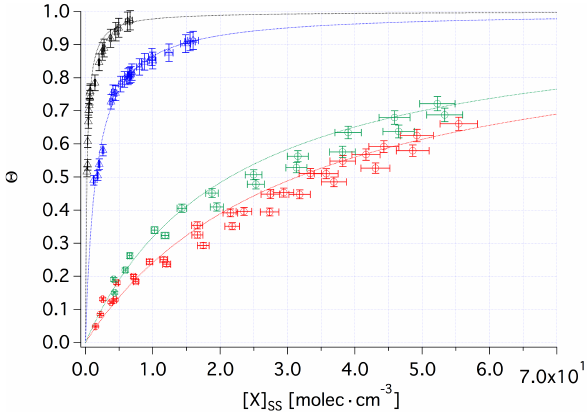
Figure 2: Wall coverage as a function of HCl and H 2 O concentration interacting with 1193 Figure 2. Wall coverage as a function of HCl and H 2 O concentra- the reactor walls according to Langmuir using data of the type displayed in Fehler! 1194 tion interacting with the reactor walls according to Langmuir using data of the type displayed in Fig. S2 in the Supplement. The red Verweisquelle konnte nicht gefunden werden. . The red symbols represent the 1195 symbols represent the interaction of pure H 2 O and the green sym- interaction of pure H 2 O and the green symbols the interaction of H 2 O in the presence 1196 bols the interaction of H 2 O in the presence of an additional HCl of an additional HCl flow F in (HCl) = 8 ⋅ 10 14 molec s -1 admitted into the reactor. 1197 flow F in (HCl)=8 × 10 14 molecs − 1 admitted into the reactor. Sim- Similarly, the black symbols represent the interaction of pure HCl, the blue symbols 1198 ilarly, the black symbols represent the interaction of pure HCl, the the interaction of HCl in the presence of an additional H 2 O flow F in (H 2 O) = 1199 blue symbols the interaction of HCl in the presence of an additional (3÷6)·10 15 molec s -1 admitted into the reactor. The parameters of the fitting curves 1200 H 2 O flow F in (H 2 O)=(3–6) × 10 15 molecs − 1 admitted into the re- may be found in Table 2. 1201 actor. The parameters of the fitting curves may be found in Table 1202